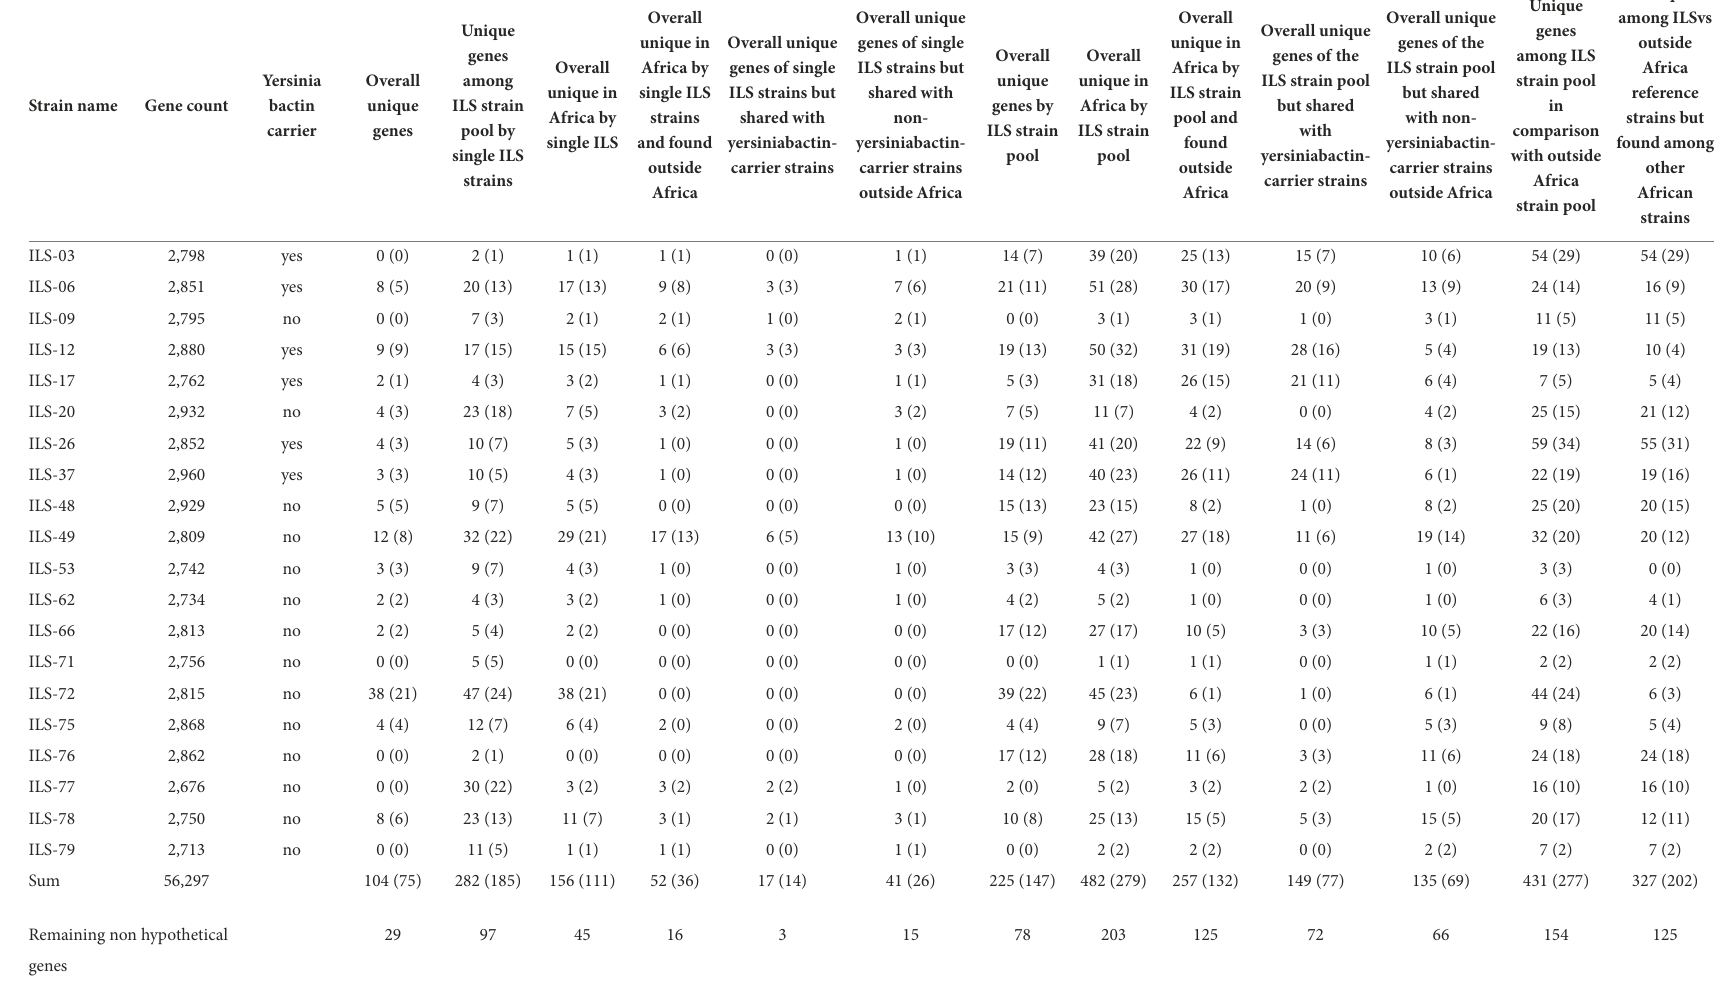
TABLE 3 Comparative genomics of 20 ILS S. aureus strains to 79 other S. aureus isolates selected according to their cgMLST